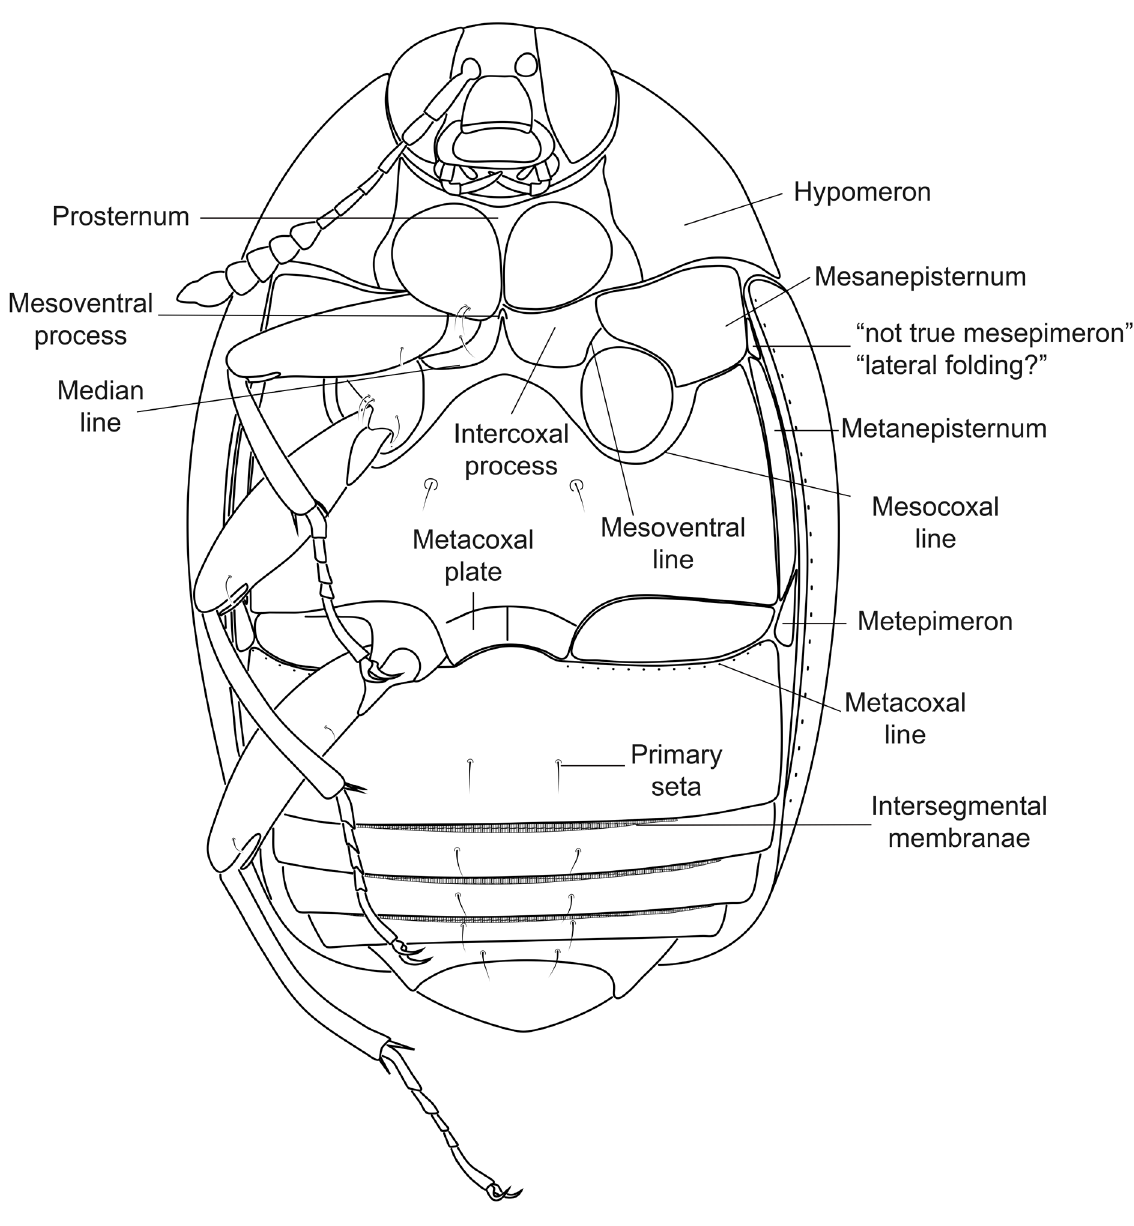
Fig. 3. Ventral terminology. Model: Cyparium collare Pic,